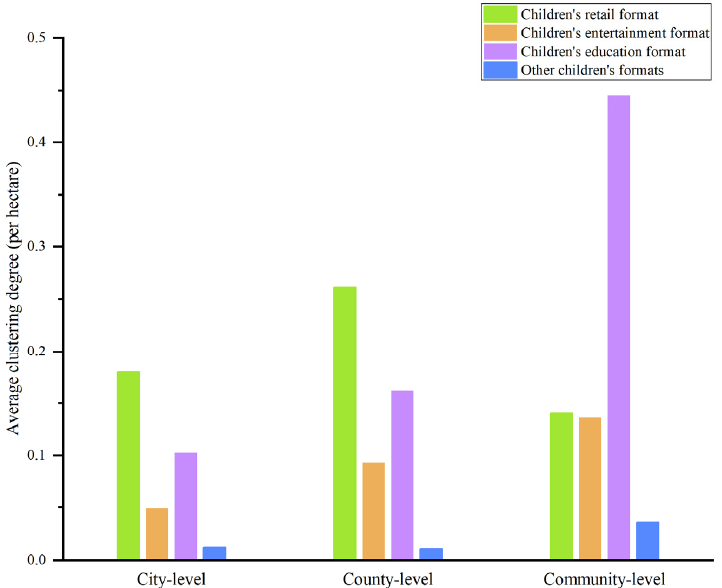
Figure 7. The difference in the proportion of 4 types of children’s business formats in 66 commercial centers in Wuhan. Data sources: the field investigation data.